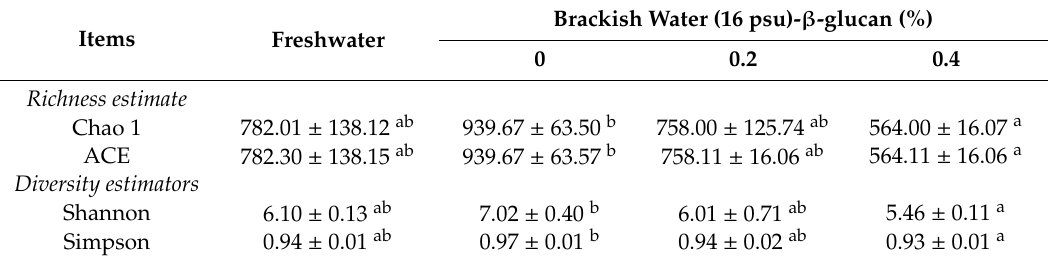
Table 4. Summary of diversity index (Shannon and Simpson) and estimated OTU richness (Chao 1 and ACE) for intestinal bacterial diversity analysis of Oreochromis niloticus fed diets with di ff erent β -glucan percentages under two salinities for 8